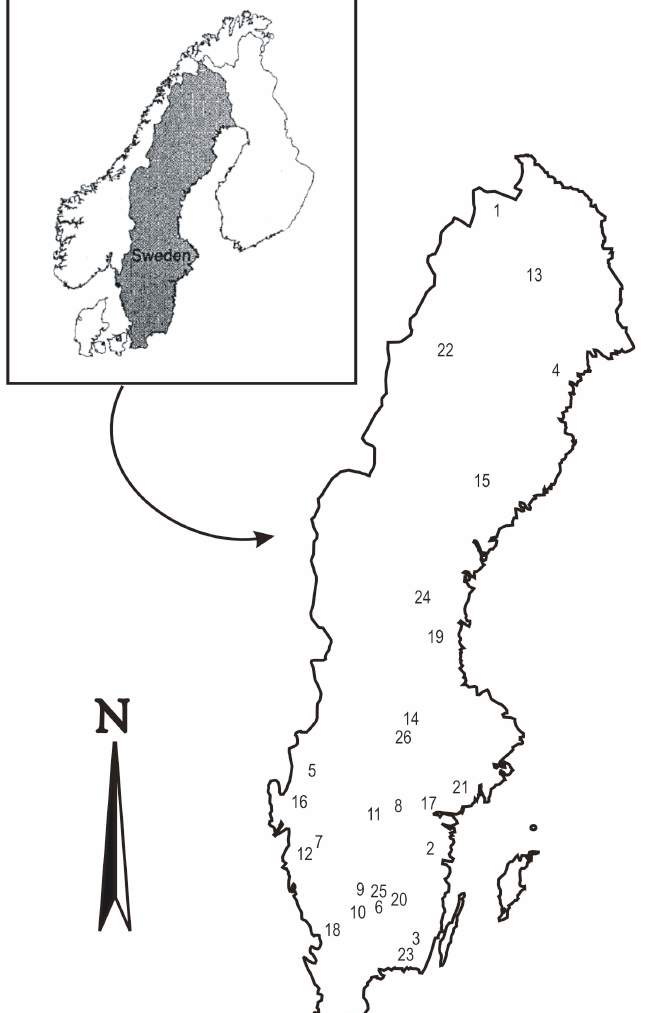
Figure 1: Map of Sweden showing the location of study lakes. See Table 1 for lake